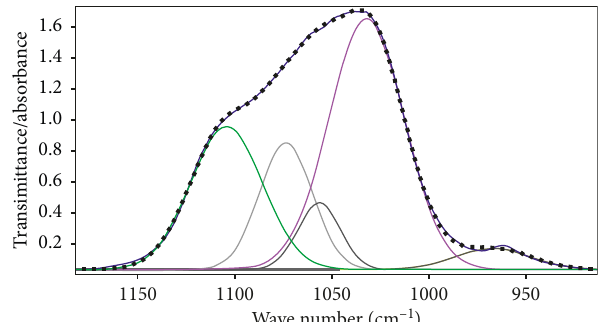
Figure 6: Original spectrum in the ] 1 ] 3PO 4 area (dark blue line) recovered by the Gaussian sum fitting (dotted-black line) and the 5 individual peaks beneath (full lines). The two peaks directly used to compute the Mineral Maturity parameter are the 1030cm − 1 peak (purple line) and the 1110cm − 1 peak (dashed-green